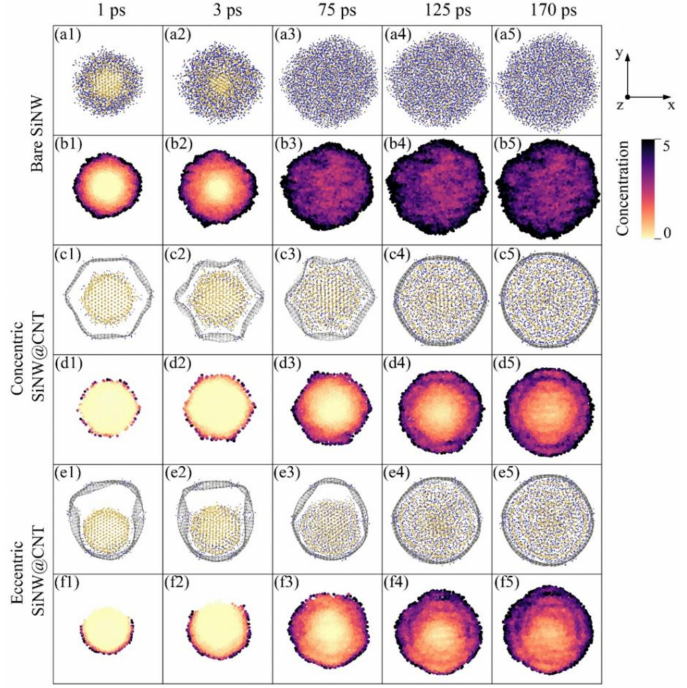
Figure 3. Morphological evolution. The cross-section snapshots for atomic structural evolution at specific simulation time during lithiation of ( a1 – a5 ) Bare SiNW, ( c1 – c5 ) Concentric SiNW@CNT, and ( e1 – e5 ) Eccentric SiNW@CNT. The lithium concentration maps at a corresponding simulation time of ( b1 – b5 ) Bare SiNW, ( d1 – d5 ) Concentric SiNW@CNT, and ( f1 – f5 ) Eccentric